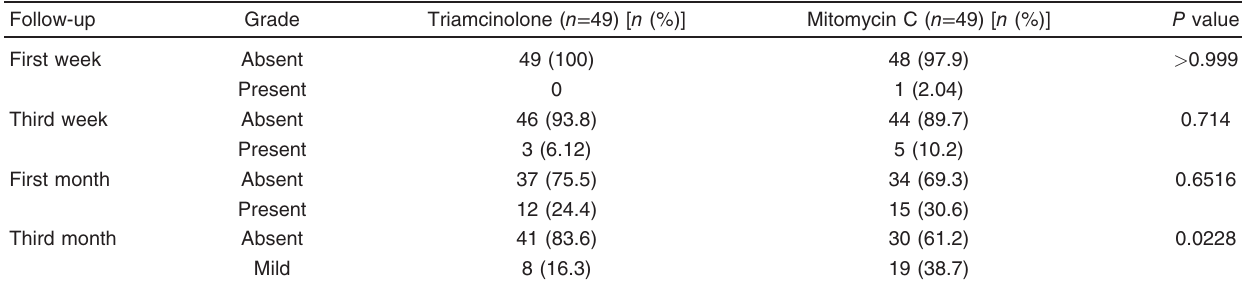
Table 2 Synechia formation during follow-up Follow-up